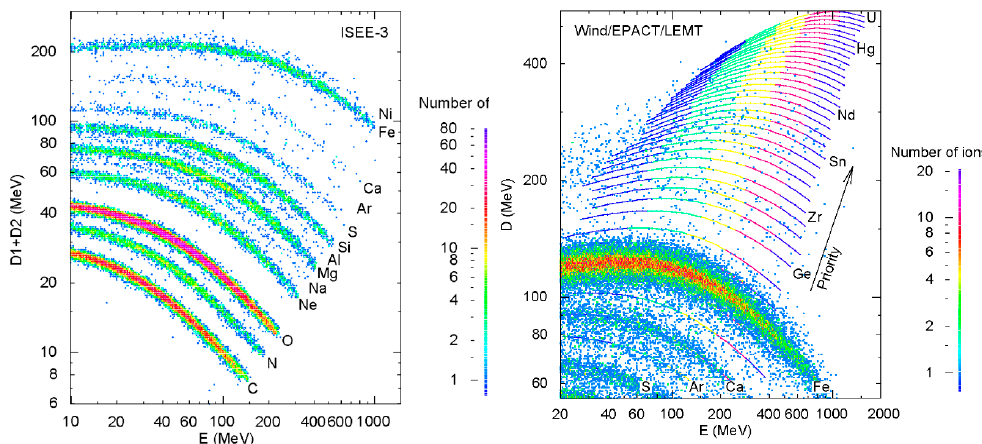
Figure 1. Response “matrices”, showing the number of ions for each dE vs. E bin, separate ions into tracks of increasing energy for each element as listed. Light elements are well resolved [52] in the left panel where energy deposit in thin detectors D1 and D2, are plotted against energy deposit in the thick E detector where ions stop.The right panel shows similar D vs. E plot for a telescope with dynamic range above Fe to Hg and U, where heavy elements above Fe are only grouped [41,42,53].